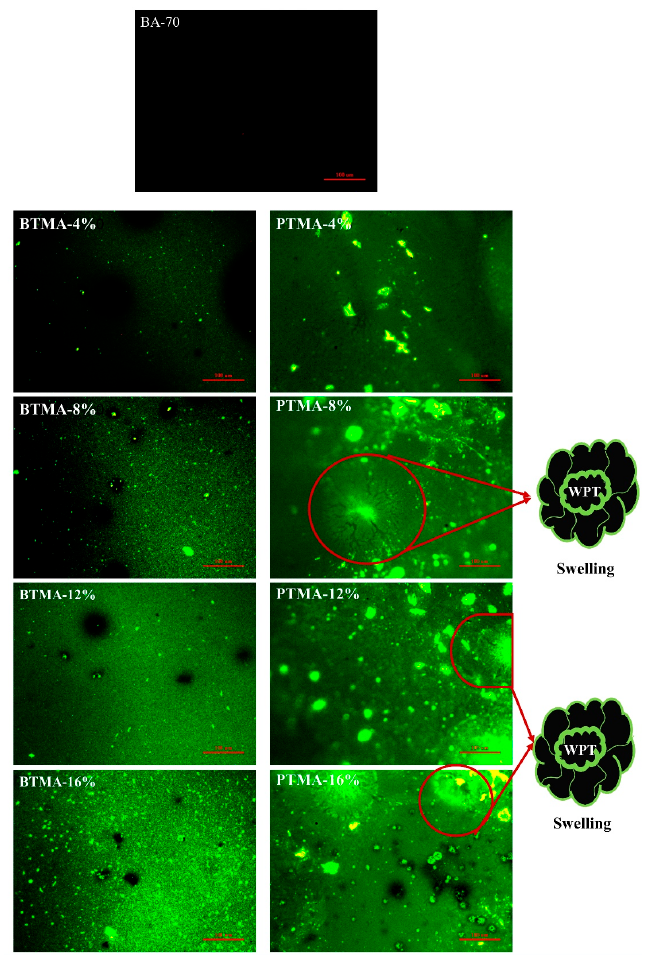
Figure 6. Fluorescence micrograph of all binders.